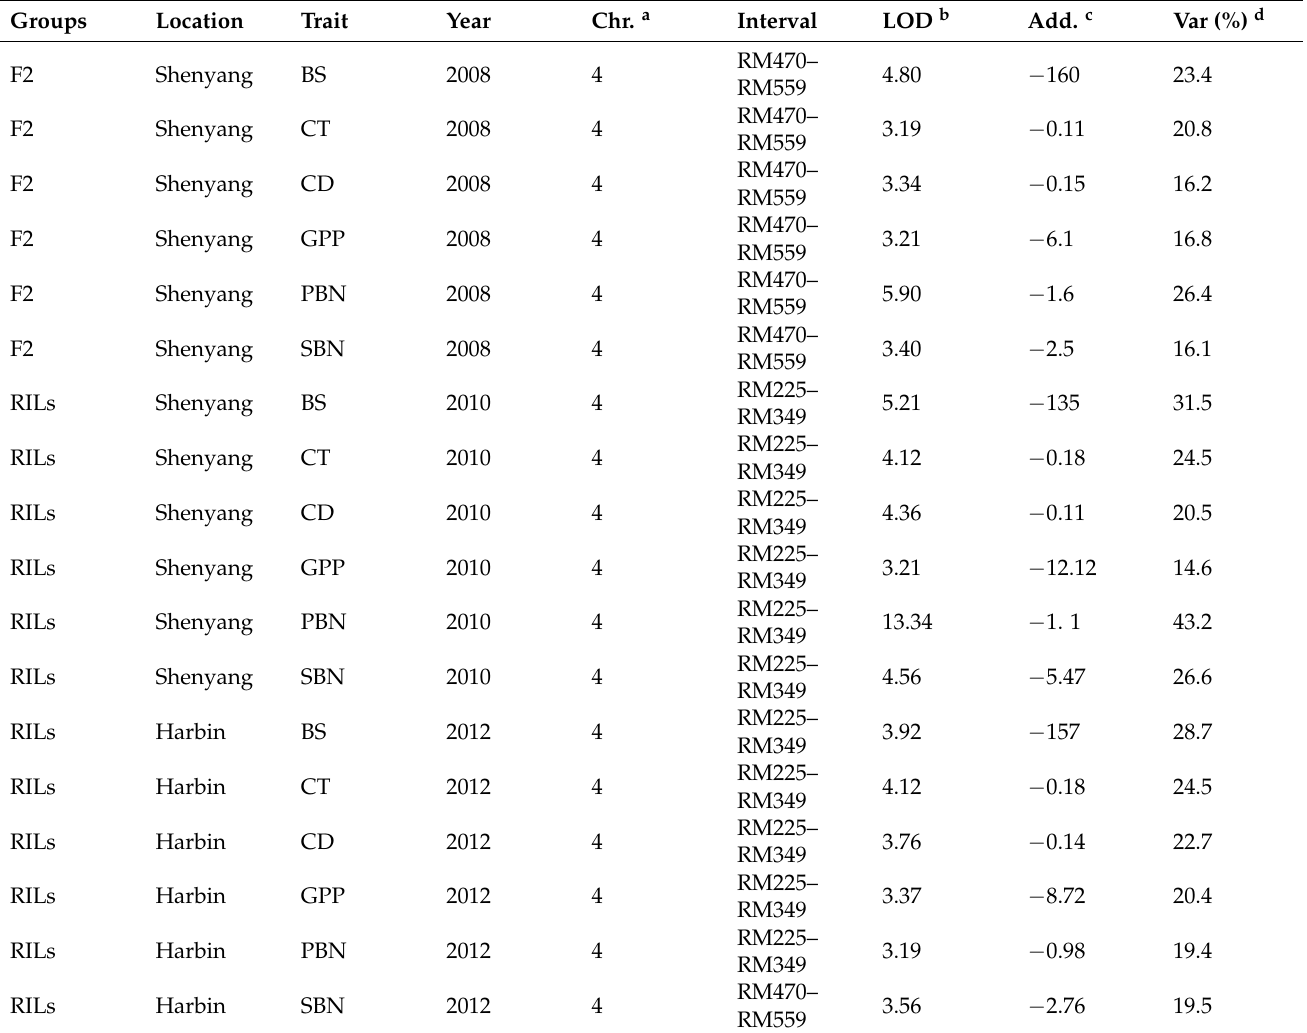
Table 2. QTL for panicle and basal culm related traits on chromosome 4 using F 2 population (176 plants) and RIL population (144 lines) of SN265-11/LTH in Shenyang and Harbin in 2008, 2010 and 2012,